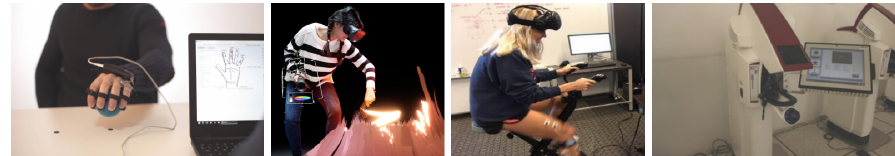
Figure 2. Selected examples that affect immersion level in VR-based education. From left: Immersive system based on wearable devices for providing on-the-job training [55]. Tilt Brushas: a tool in VR education [56]. Virtual Reality Cycling Platform [61]. Haptic feedback system used with Simodont for teaching dental procedures